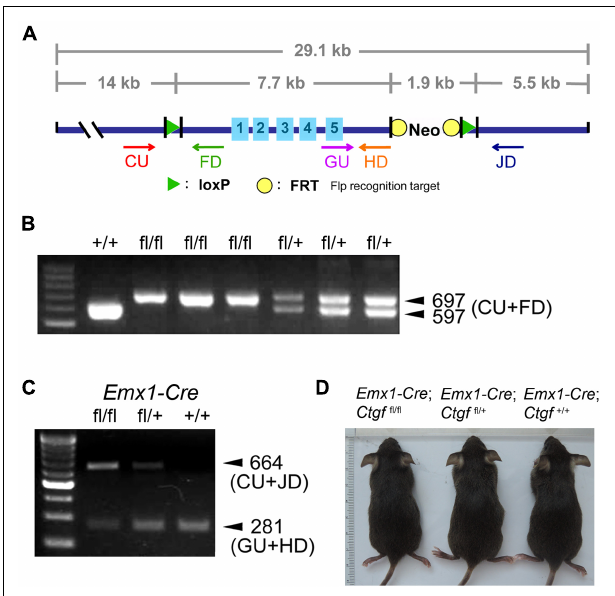
FIGURE 2 | Generation and genotyping of forebrain-specific conditional Ctgf knockout mice. The strategy for generating Ctgf knockout (KO) mice (A) . A targeting vector carrying loxP -flanked Ctgf (exons 1–5) was designed employing a bacterial artificial chromosome contained mouse genomic DNA encompassing Ctgf of 29.1 kb. PCR products obtained from tail samples for distinguishing floxed (fl) Ctgf allele (B) . Genotyping of control ( Emx1-Cre ; Ctgf + / + ), heterozygous ( Emx1-Cre ; Ctgf fl / + ) and homozygous ( Emx1-Cre ; Ctgf / fl / fl ) knockout mice using forebrain samples (C) . The outward appearances of control ( Emx1-Cre ; Ctgf + / + ) and mutant ( Emx1-Cre ; Ctgf fl / + , Emx1-Cre ; Ctgf fl / fl ) mice (D) .